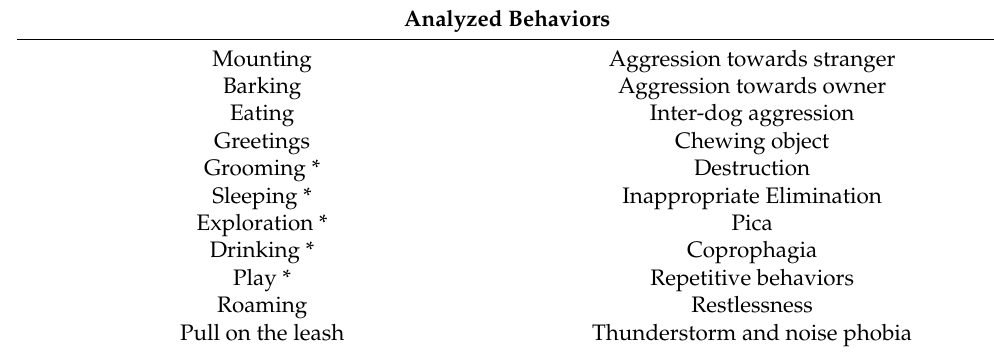
Table 1. Behaviors analyzed during the study. Variables marked with “*” were collected through a Likert scale. For Grooming, Sleeping, Exploration, and Drinking behaviors, the Likert scale had 3 points: poor, normal, excessive; instead, for the Play behavior, the Likert scale had 5 points: absent, poor, normal, strong, obsessive), and the others behaviors were collected in a binary way (Yes/No). Analyzed Behaviors Mounting Aggression towards stranger Barking Aggression towards owner Eating Inter-dog aggression Greetings Chewing object Grooming * Destruction Sleeping * Inappropriate Elimination Exploration * Pica Drinking * Coprophagia Play * Repetitive behaviors Roaming Restlessness Pull on the leash Thunderstorm and noise phobia